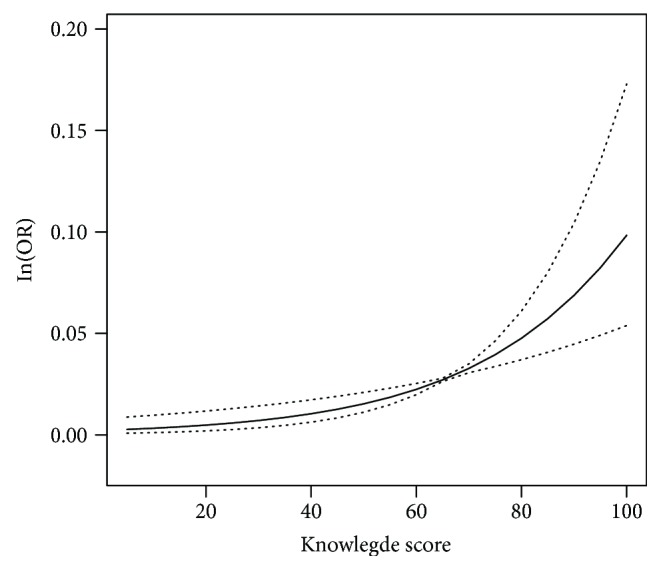
Curve fitting between knowledge score and ln(OR). OR for achieving combined target goal associated with an increase in knowledge score. Adjusted for age, gender, educational attainment, marital status, family history of diabetes mellitus, duration of diabetes mellitus, current medical treatment, and smoking status. The dotted line presented 95%CI.